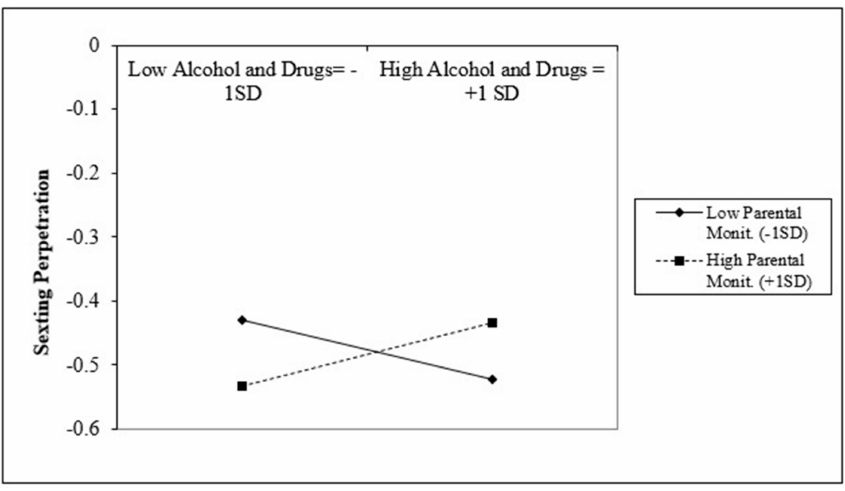
Figure 4. Interaction between alcohol and drug use and parental monitoring for LGB